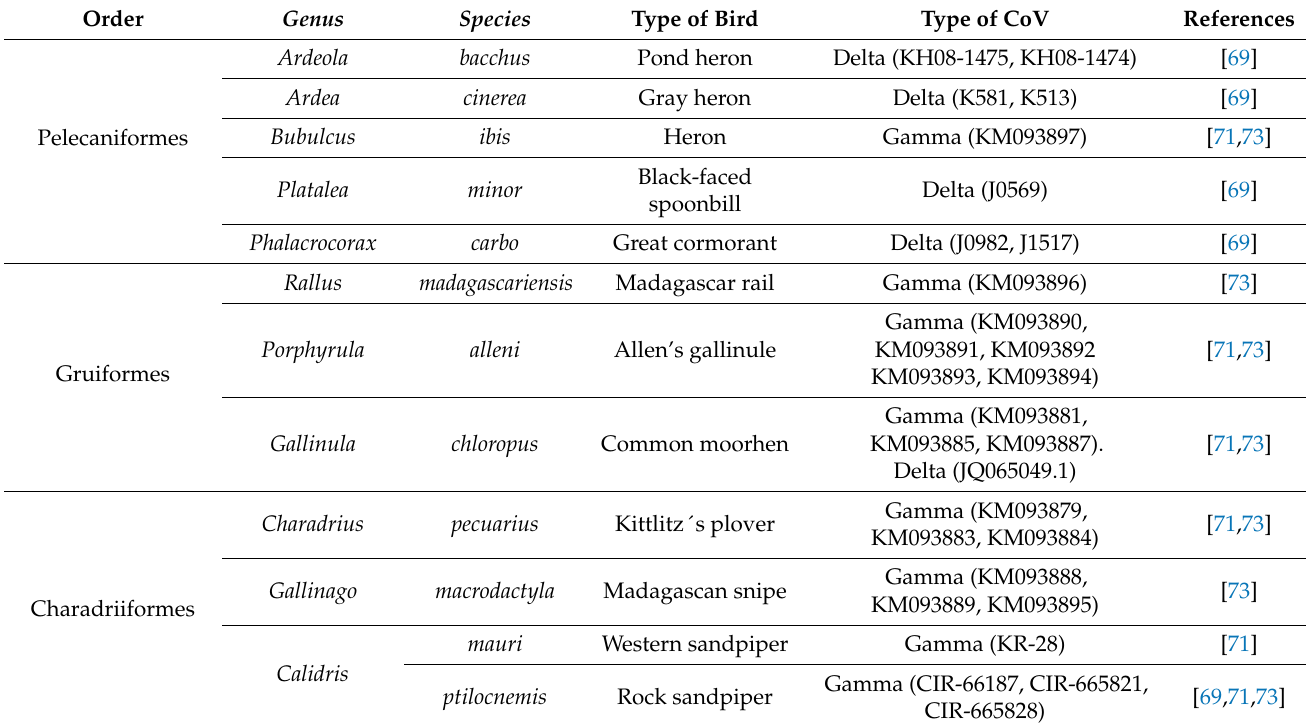
Table 3. Gammacoronavirus and Deltacoronavirus reported in aquatic